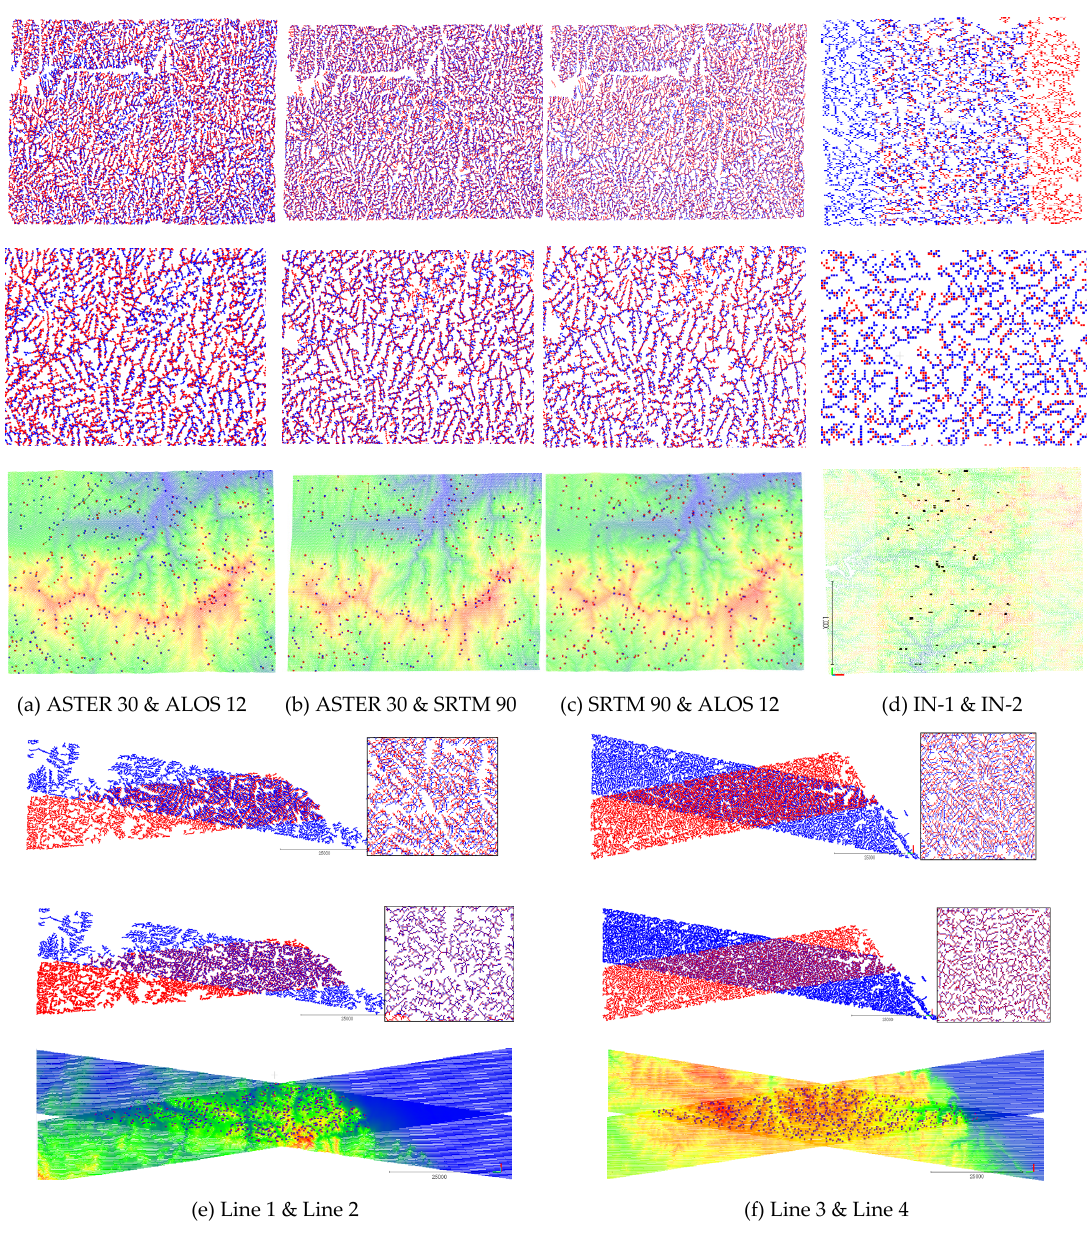
Figure 9. Registration of the proposed method. ( a – f ) are the registered results of ASTER 30 & ALOS 12, ASTER 30 & SRTM 90, SRTM 90 & ALOS 12, IN-1 & IN-2, Line 1 & Line 2 and Line 3 & Line 4. From the top to bottom are the original ridgelines, registered ridgelines and correspondences